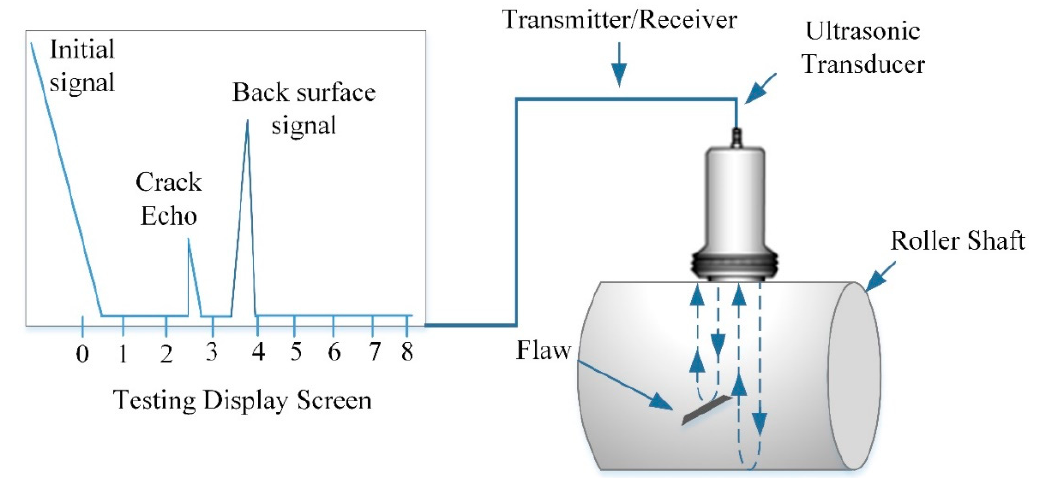
Figure 5. Schematic diagram of the ultrasonic testing (UT) set-up, depicting the test screen and compression probe.